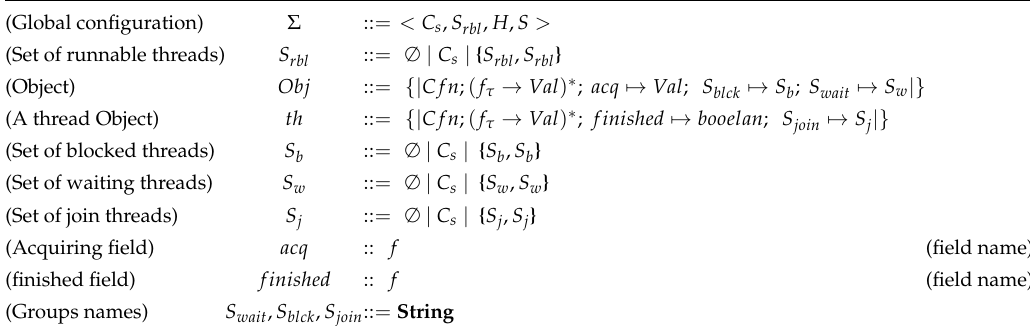
Table 7. Semantic domains for a multi-threaded program.